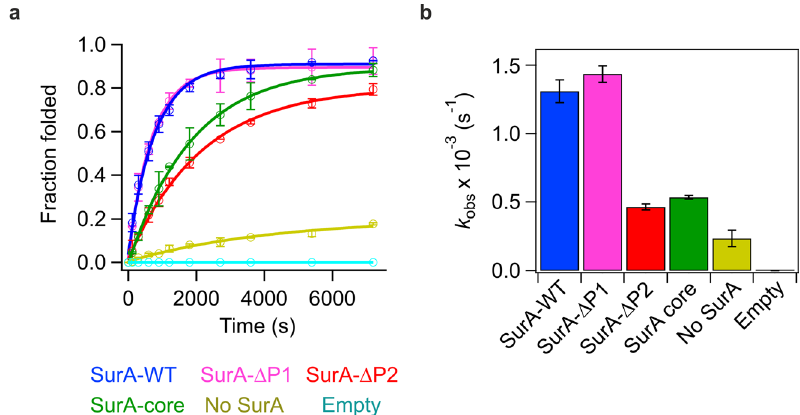
Fig. 4 The presence of the SurA core and P2 domains are required for maximal rate enhancement of tOmpA folding on BAM. a Fraction folded of tOmpA in the presence or absence of BAM and SurA variants at different time points as measured by cold SDS – PAGE. Points are the mean of two independent replicates and error bars represent the range of values covered by the replicates. For BAM-containing samples fi ts to a single exponential equation are shown. In the absence of BAM no folding is observed. b Observed rate constants ( k obs ) from kinetic experiments in ( a ). Error bars represent the error on the fi t to a single exponential. Example SDS – PAGE gels of the folding reactions are shown in Fig. S11. Samples contained 1 μ M BAM (where included) in proteoliposomes containing E. coli polar lipid extract (see the “ Methods ” section), 2 μ M tOmpA, 10 μ M SurA variant (where included) in